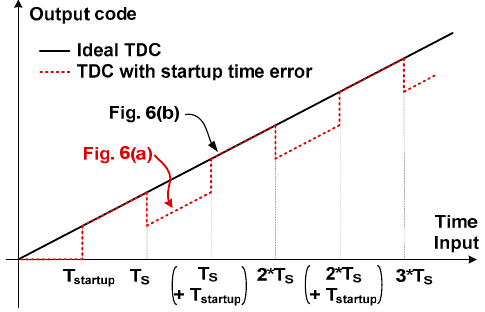
Figure 7. Input and output characteristics of the TDC for a large T startup .